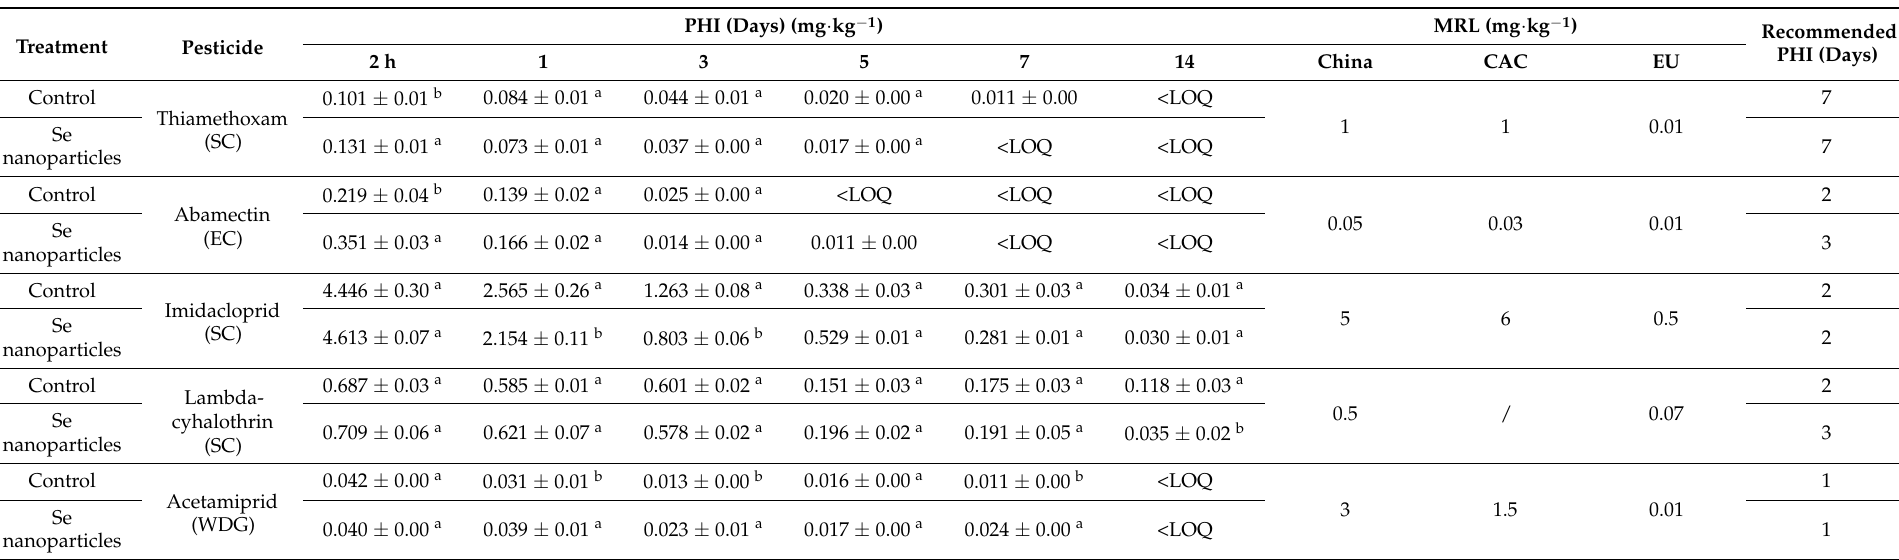
Table 5. Residue levels at different pre-harvest intervals after applying the recommended dose combined with 2 g · ha − 1 Se nanoparticles.